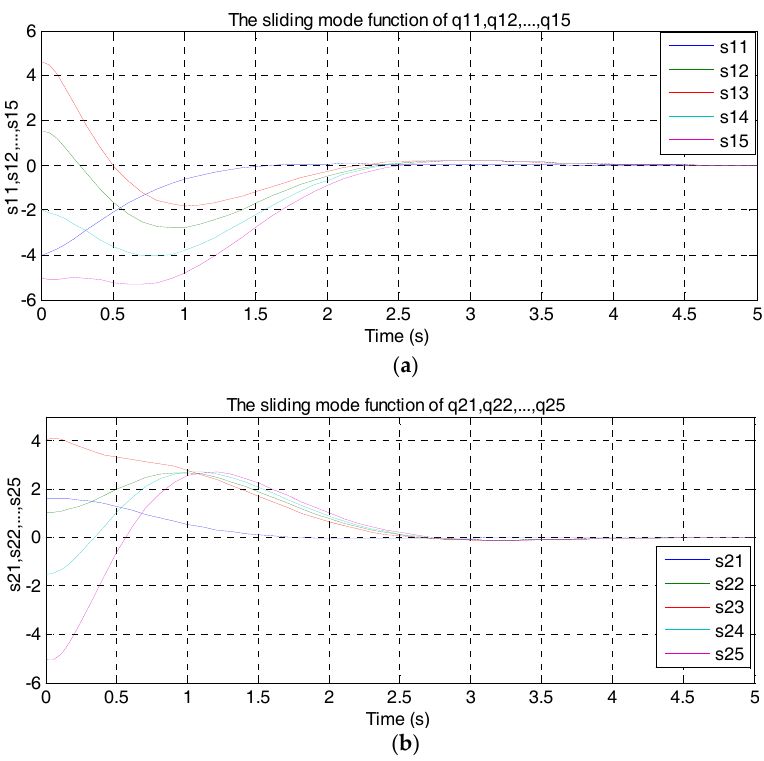
Figure 6. Response of sliding mode function of multi-agent system with q 1 i , q 2 i , respectively. ( a ) Response of s 1 l ; ( b ).Response of s 2l .